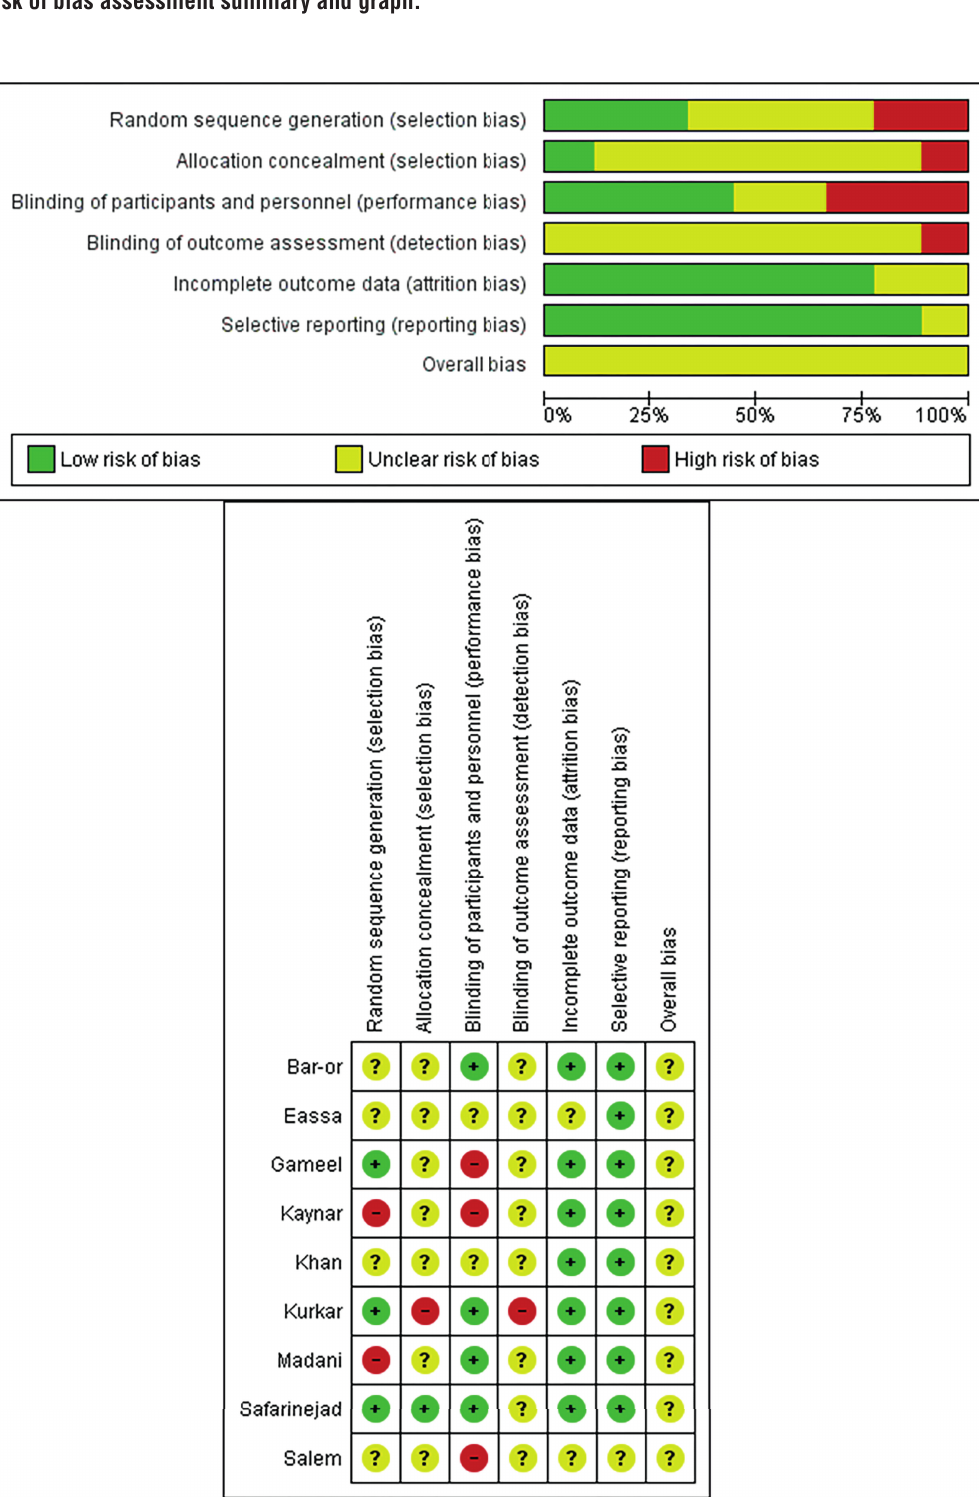
Figure-2 - Risk of bias assessment summary and